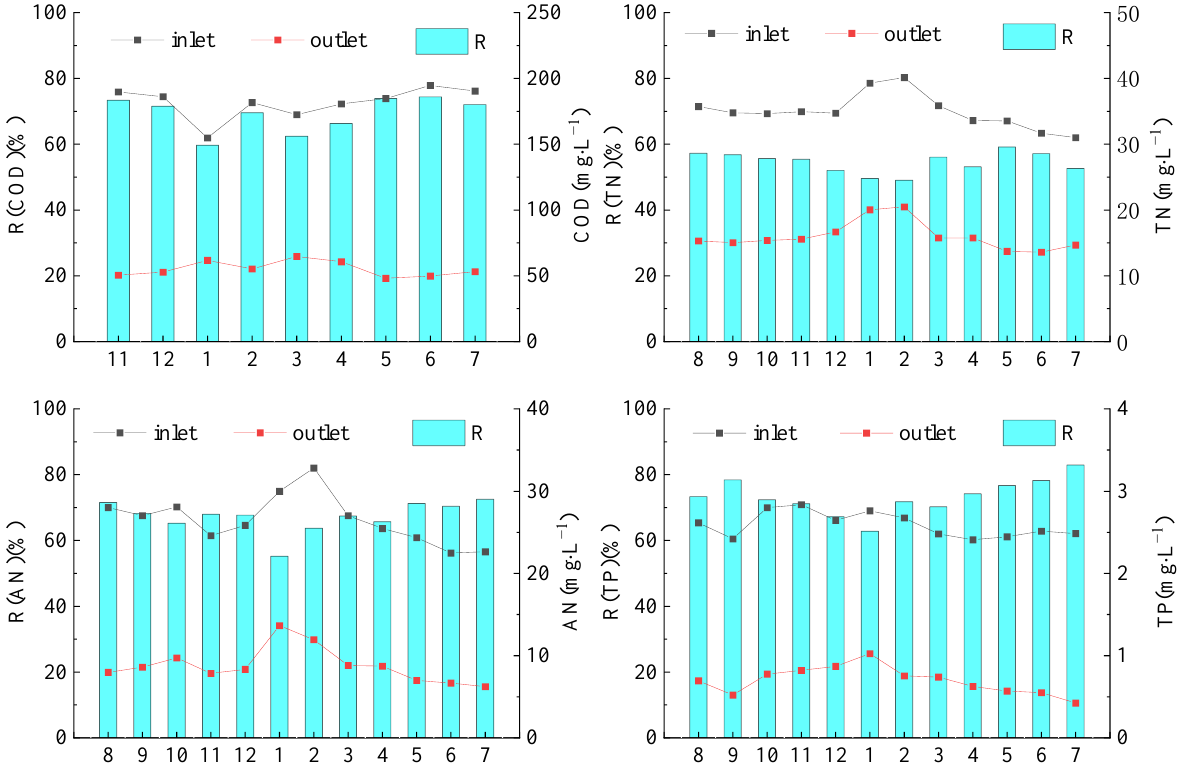
Figure 2. Removal capacity of the TIEPD. Note: Inlet: inlet concentration; Outlet: outlet concentration; R: removal efficiency. The x-axis represents different months (observed from August 2018 to July 2019 except for COD, which was observed from November 2018 to July 2019). The same notation is used in subsequent figures and tables.